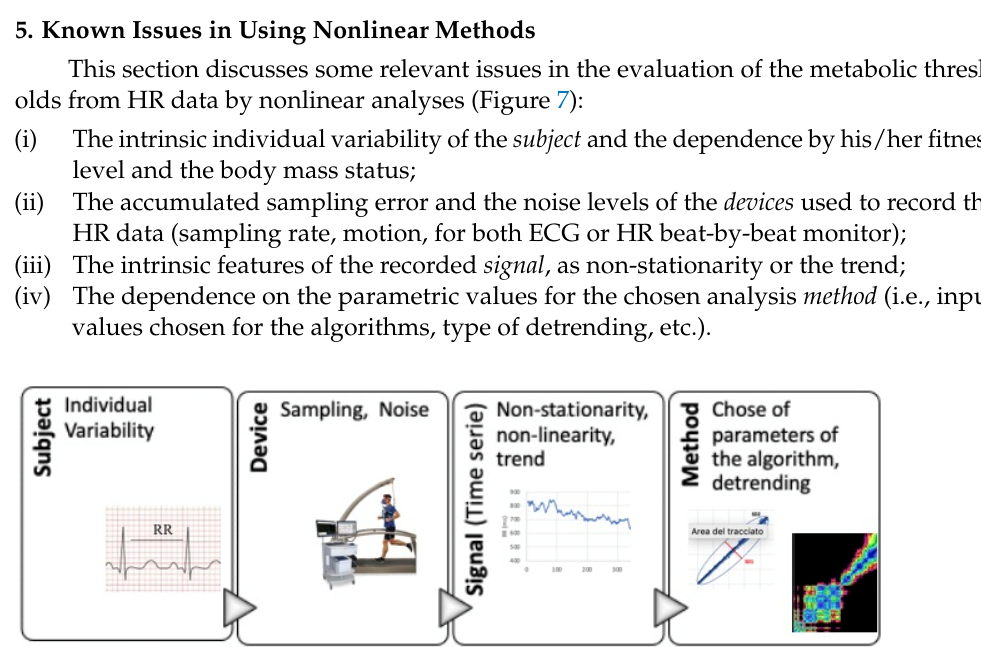
Figure 7. From the subject to the method: a presentation of the principal limitations in the HR data processing. In the insets: ECG, Experimental set: treadmill and facemask, Quark RMR-CPET Cosmed, Rome, Italy.